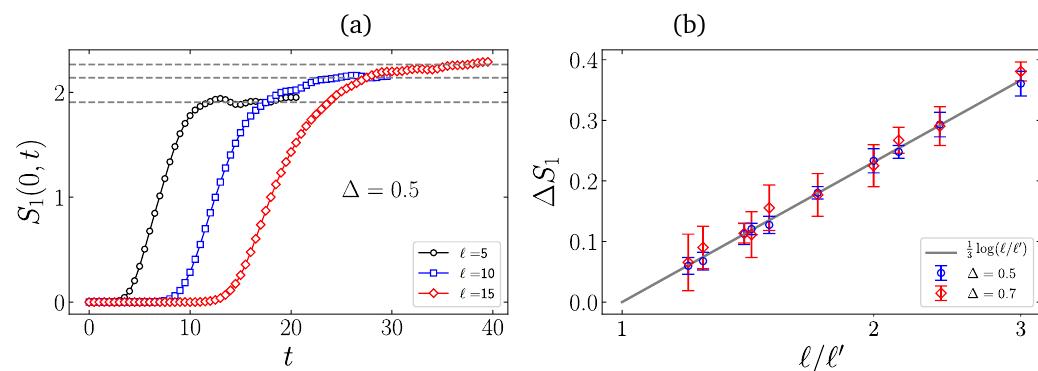
Figure 10: (a) Numerical analysis of the half-system entanglement at large times t (cid:29) (cid:96) for a lattice of size L = 120 with ∆ = 0.5 and different domain sizes (cid:96) . We observe a saturation of the entanglement to a constant value that we extracted with a best fit of our data (dashed-lines). (b) Comparison of the numerical results with the Ansatz in Eq. (88) using the proxy (89) for ∆ = 0.5,0.7. Although finite-size effects affect our data, we see a good agreement, which we expect to improve with larger values of L , (cid:96) and t . In the plot, error bars are extracted from the covariance matrix of the fitting